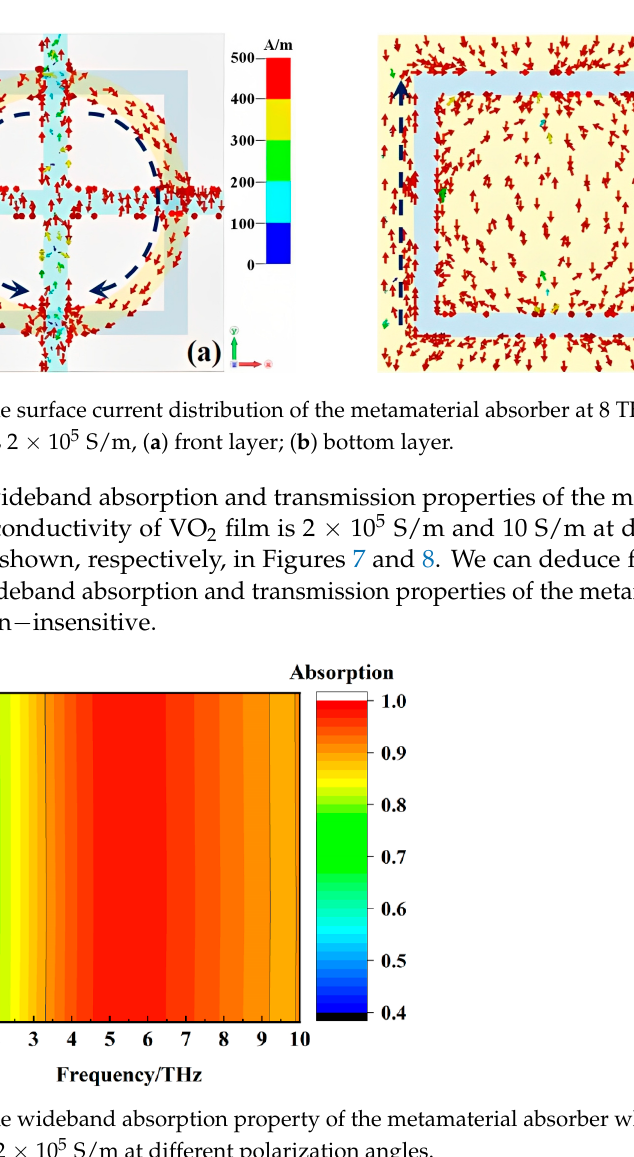
Figure 8. The transmission property of the metamaterial absorber when the conductivity of VO 2 film is 10 S/m at different polarization angles.